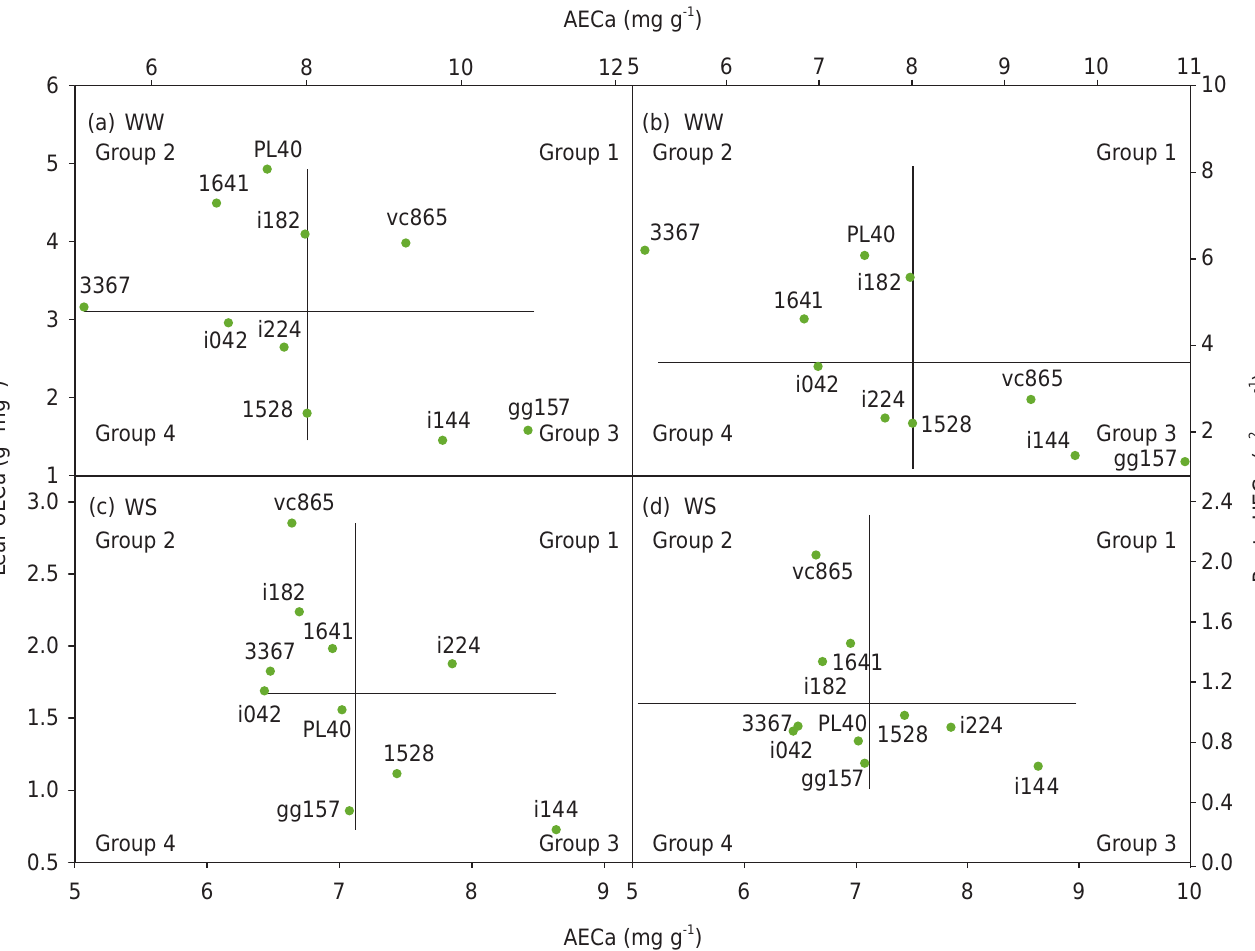
Figure 4. Calcium absorption efficiency (AECa) and Ca use efficiency in leaves (leaf UECa) (a), and roots (root UECa) (b) of well-watered (WW) plants; and Ca absorption efficiency (AECa) and Ca use efficiency in leaves (leaf UECa) (c) and roots (root UECa) (d) of water- stressed (WS) seedlings of ten Eucalyptus